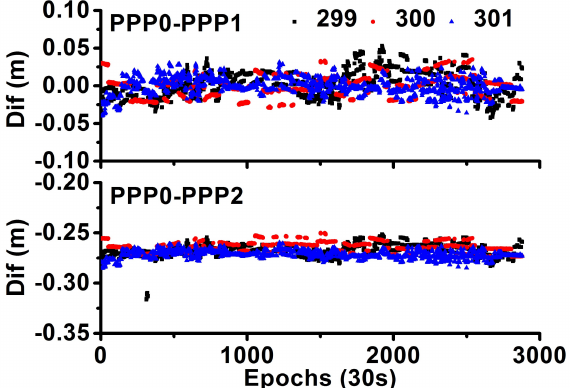
Figure 6. Comparison of system bias between different